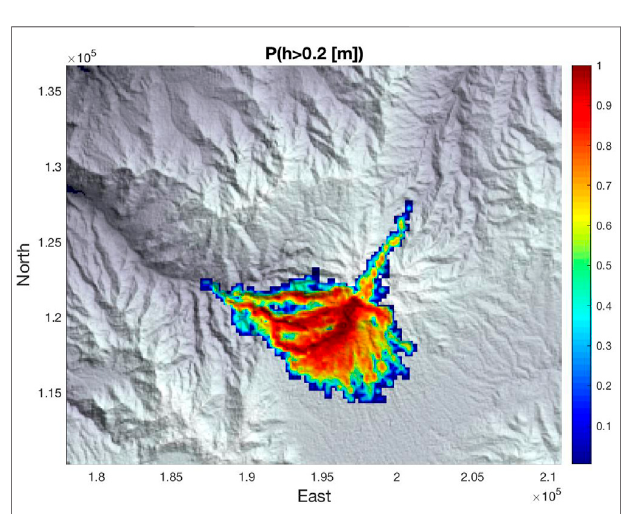
FIGURE 10 | Titan2D emulator based probability of exceeding 0.2 m fl ows in Scenario 3. Note similarity of probability of noticeable fl ow extent to mapped extent of Cortadera and Espino fl ows.